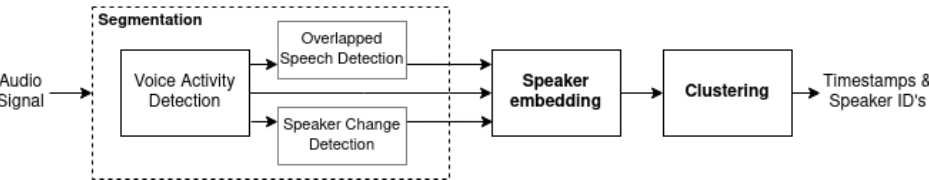
Figure 1. Basic structure of the diarization system with clustering based on